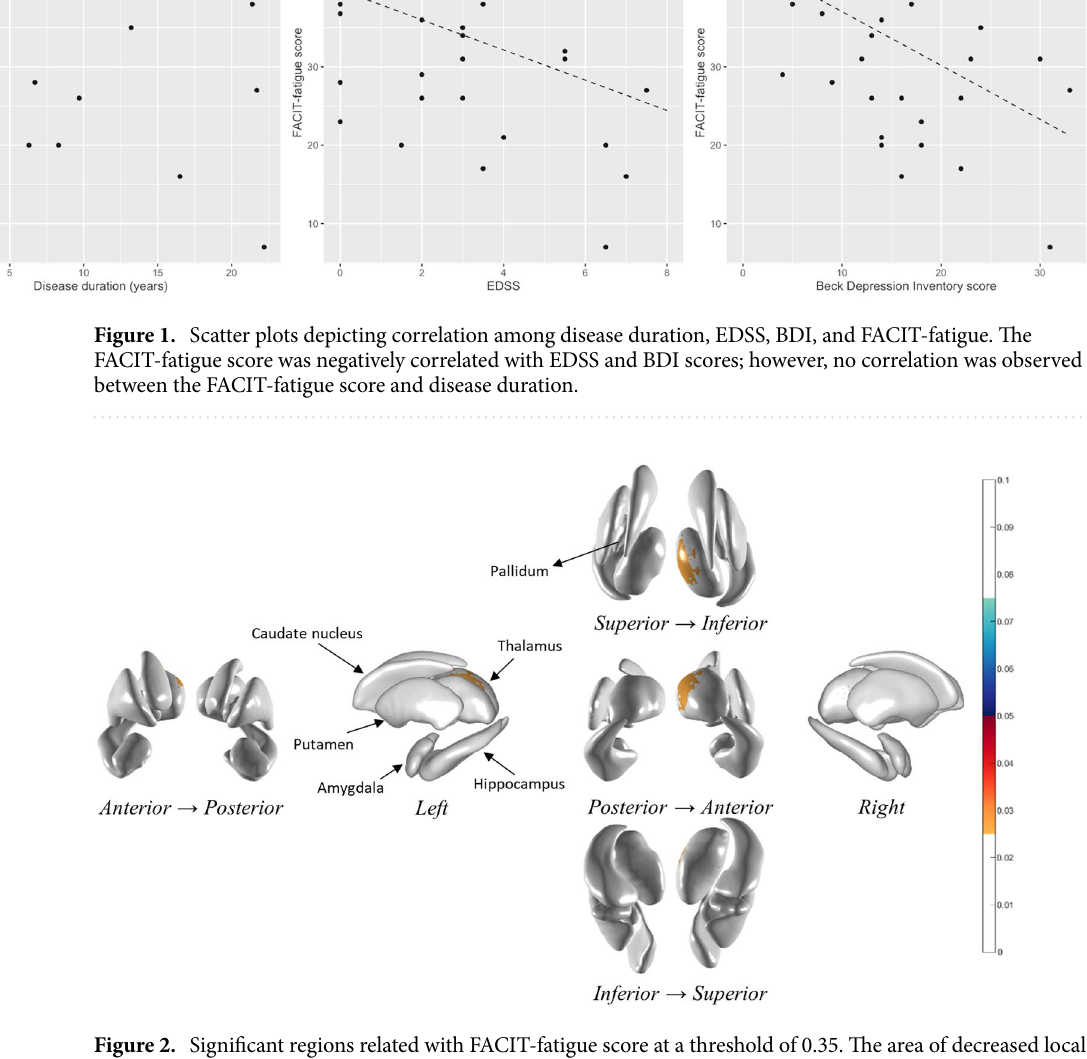
Figure 2. Significant regions related with FACIT-fatigue score at a threshold of 0.35. The area of decreased local shape volume correlated with FACIT-fatigue score involved the right thalamus in patients with